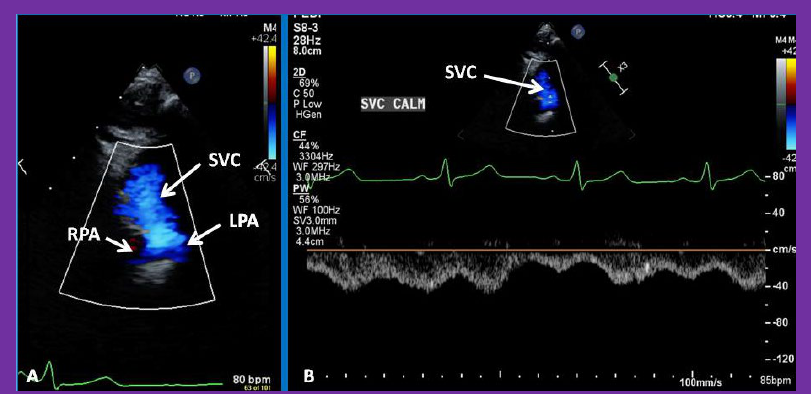
Figure 25. Selected video frames from suprasternal notch view demonstrating bidirectional Glenn shunt; the superior vena cava (SVC) is shown emptying into the right (RPA) and left (LPA) pulmonary arteries by color flow imaging ( A ). Low Doppler flow velocity across the shunt ( B ) indicates unobstructed Glenn.